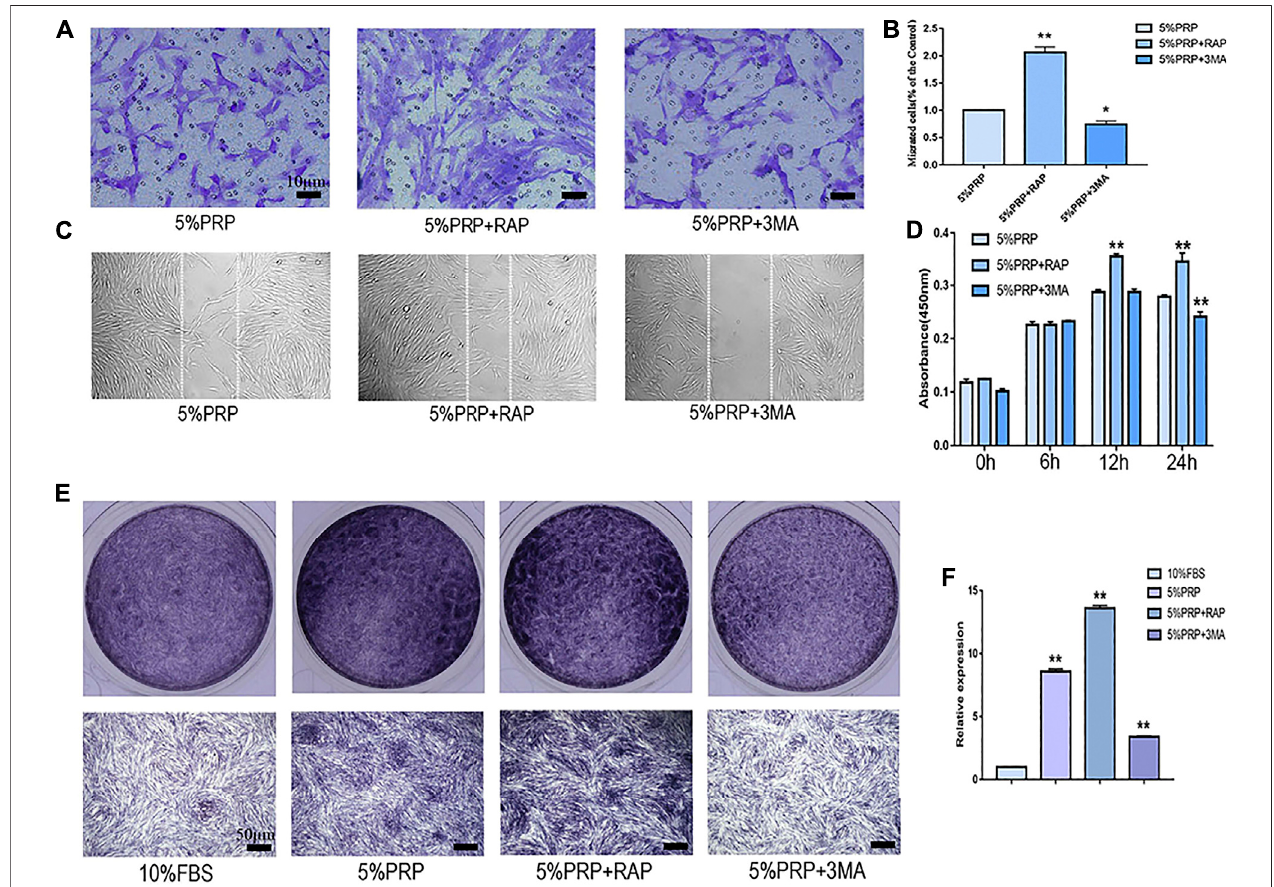
FIGURE4| Cell migration, proliferation, and osteogenicdifferentiation were suppressed byautophagy inhibitor and promoted byautophagy agonist. hDPCs were treatedwith5%PRP,rapamycin(RAP)(100 nM)+5%PRP,or3-methyladenine(3-MA)(5 mM)+5%PRP. (A) Bytranswellassay,representativeimagesofthemigrated cells in different groups (scale bar, 10 μ m). (B) The graph shows the number of migrated cells in different groups by transwell assay. (C) Representative images of the migrated cells were evaluated by scrape assay. (D) The CCK-8 assay was used to assess the proliferation ratio up to 24 h. (E) ALP staining of the four groups on day 7 (scale bar, 50 μ m). (F) ALP mRNA expression was analyzed by quantitative PCR. Experiments were repeated three times. Data in (B), (D), (E) are presented as mean ± standard deviation. Signi fi cantly different groups, * p < 0.05, ** p <